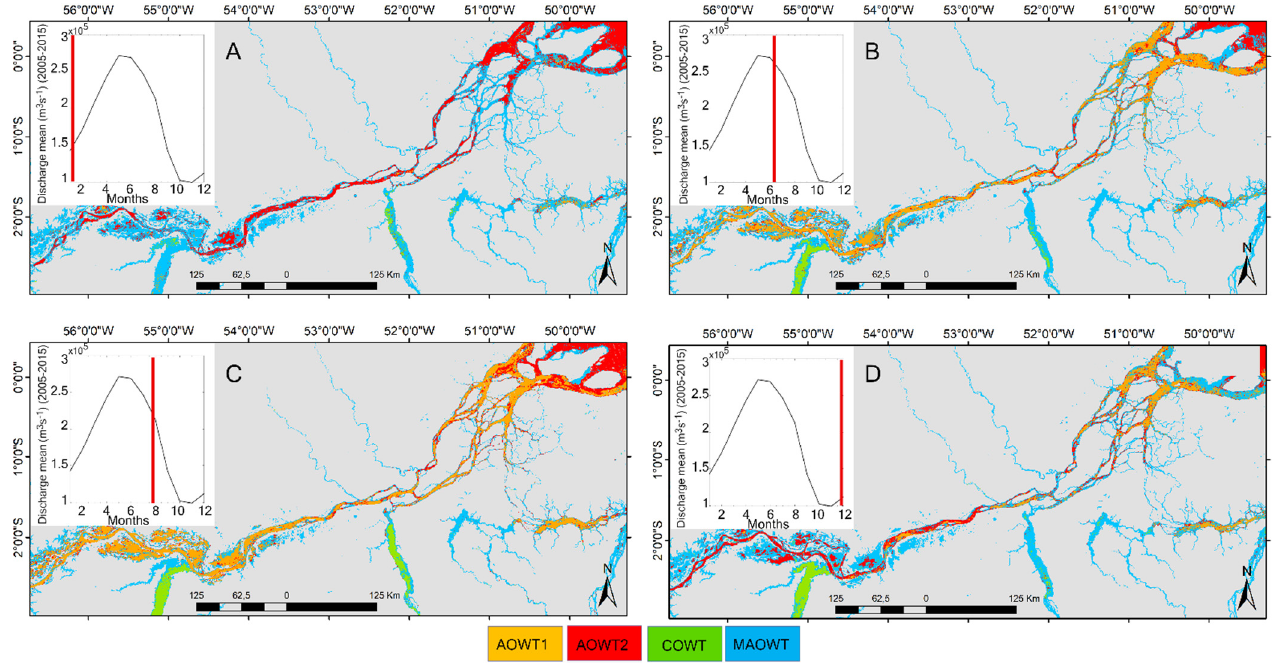
Figure 6. Inset, mean seasonal discharge of the Lower Amazon (2005–2015), with the seasonal sampling shown in red; Mahalanobis classification with the Amazon Optical Water Type 1 (AOWT1) in yellow, Amazon Optical Water Type 2 (AOWT2) in red, Clear Optical Water Type (COWT) in green, and Mixed Amazonian Water Type (MAOWT) in blue. ( A ) rising water image composite; ( B ) high water composite; ( C ) falling water composite; and ( D ) low water